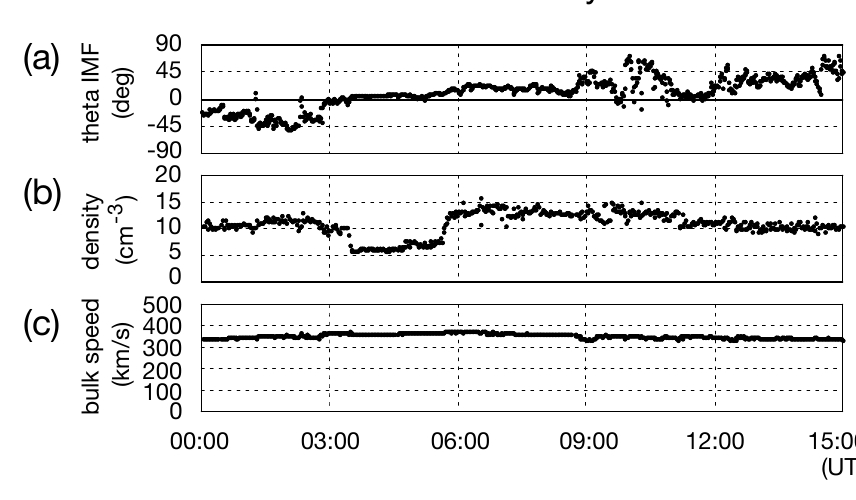
Fig. 3. Solar wind observations by the Wind spacecraft between 00:00–15:00 UT on 6 February 1996. From the top, (a) the latitudinal angle of the IMF ( θ IMF ), (b) the solar wind density ( N SW ), and (c) the bulk speed of the solar wind flow ( V SW ) are presented. The convection time of the solar wind from the Wind to the Earth’s magnetosphere ( ∼ 1 h) is not included in the